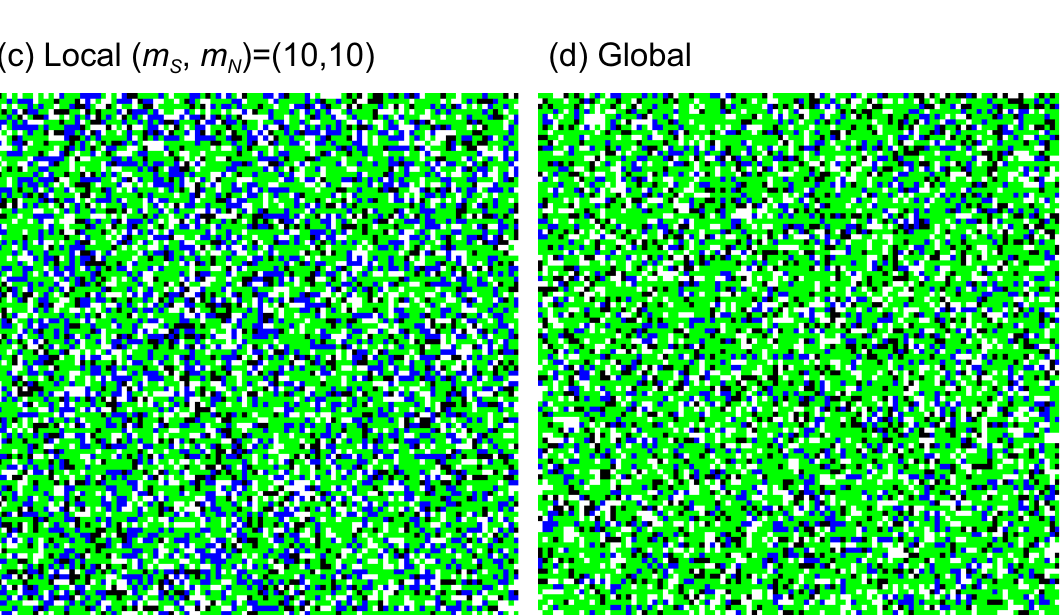
Figure 6. Typical spatial patterns at the final stage ( t = 1500 ). ( a ) Interactions occur between adjacent cells (local interaction). Nobody can move around ("lockdown"). ( b ) Local interaction. Only agent S can move around ( m S = 10 , but m j = 0 for j = S ). ( c )Local interaction. Mobile agents are limited to S, N and R N ; namely m j = 10 for j = S, N, R N but m k = 0 for k = Q, R Q ). ( d ) Global interaction (random distribution). Each site is either empty (white) or occupied by S (blue), R N (green) or R Q